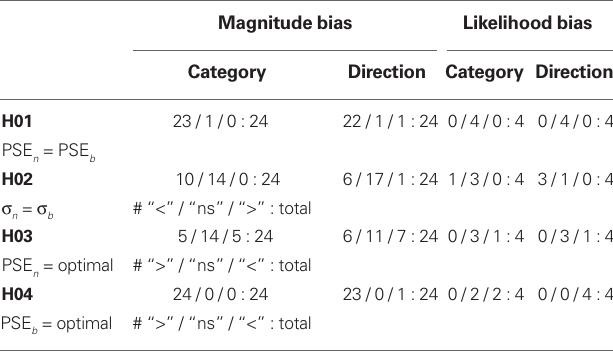
Table 1 | Summary of the reward magnitude and reward likelihood